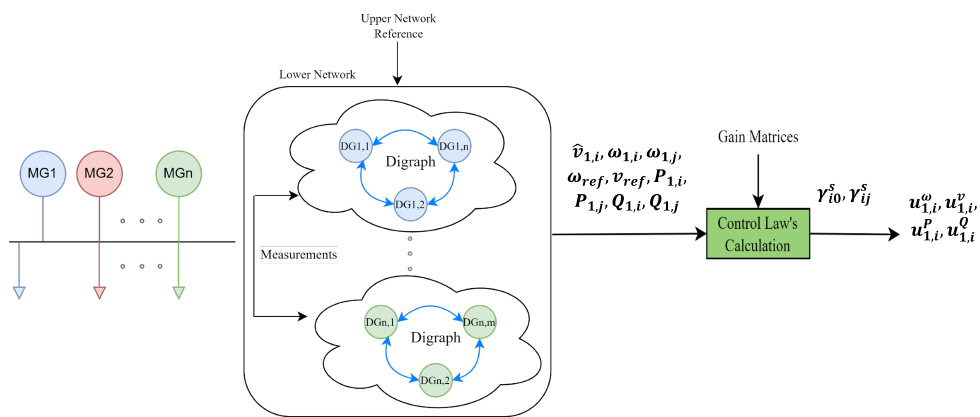
Figure 6. Implemented secondary-tertiary multi-layer communication approach for a cluster of